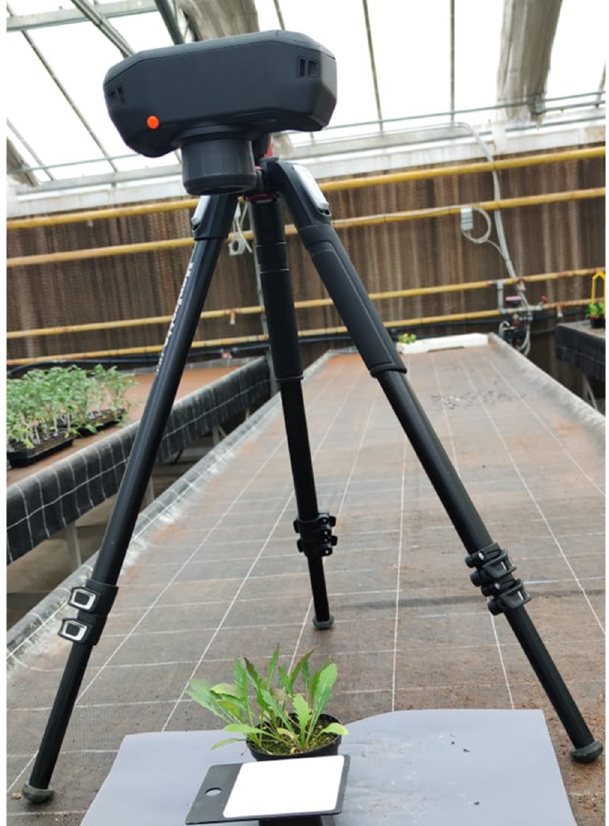
Figure 1. Front view of the image acquisition station, equipped with snapshot Specim IQ camera for images in visible and near-infrared spectra, mounted on an ebb-and-flow bench for potted wild rocket cultivation.